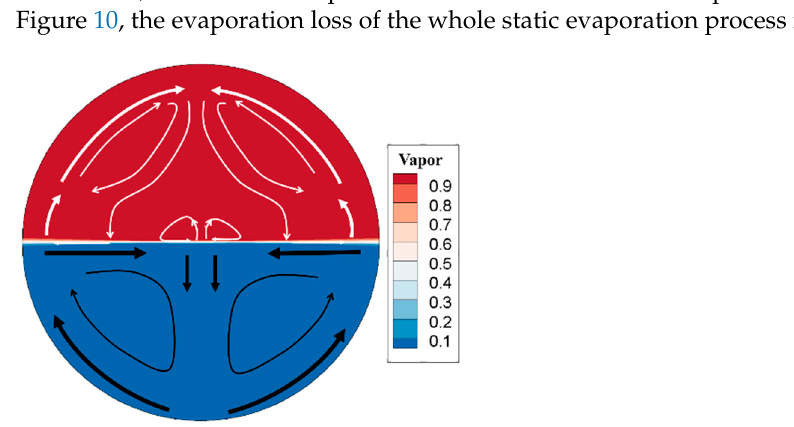
Figure 8. Direction of vapor–liquid flow during the static evaporation.